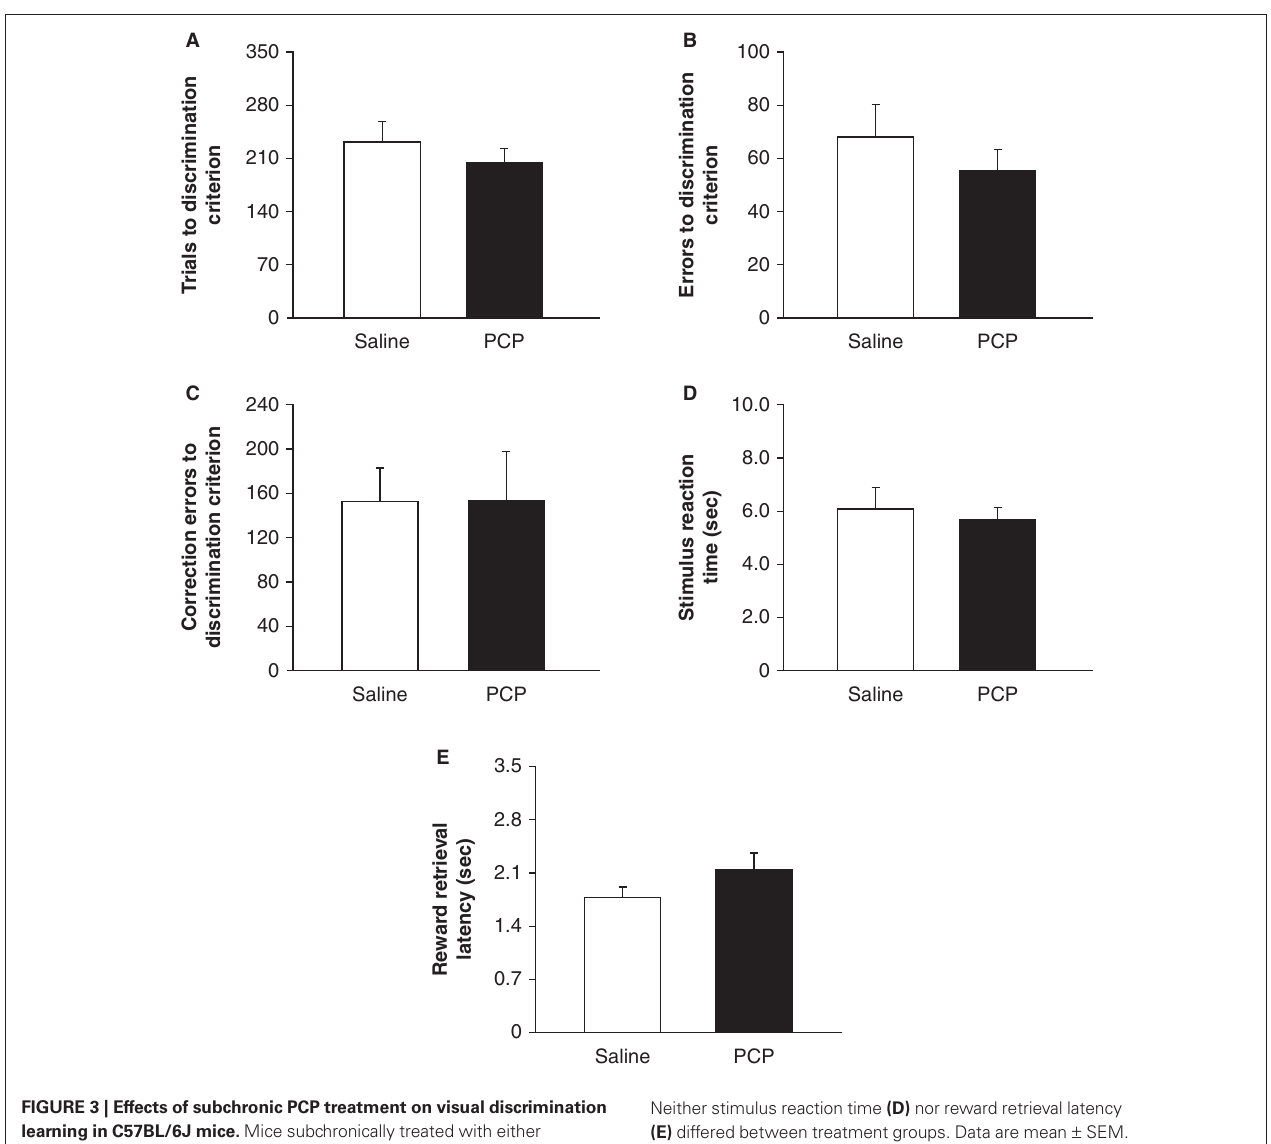
Neither stimulus reaction time (D) nor reward retrieval latency (E) differed between treatment groups. Data are mean ± SEM. n = 8 per treatment. # p < 0.05 vs. inanimate/same treatment group, * p < 0.05 vs.